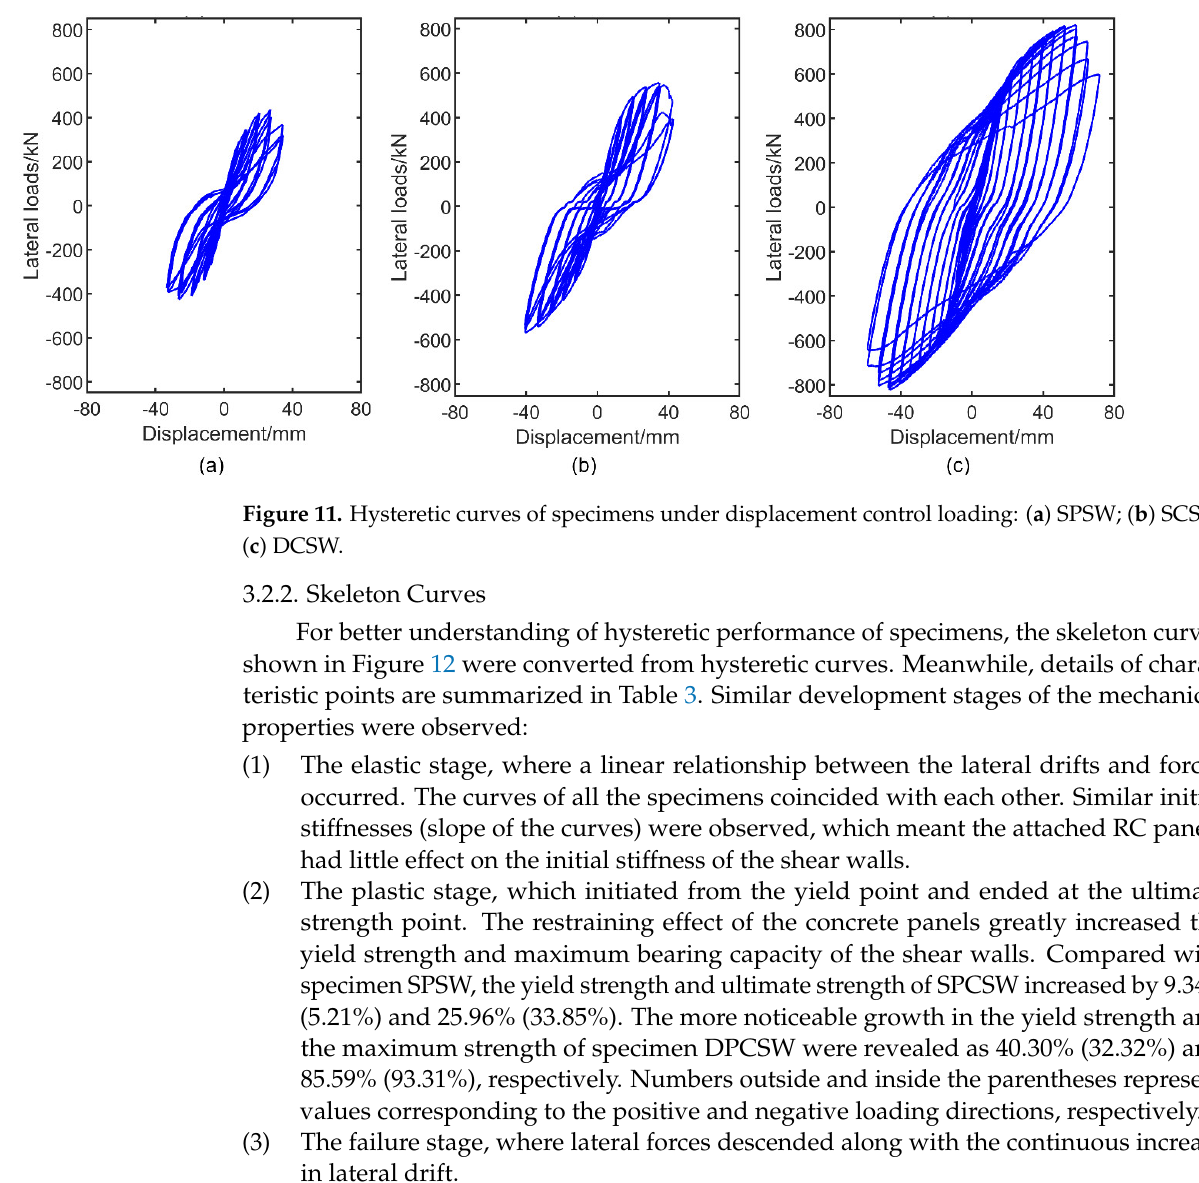
Figure 10. Failure mode of tested specimens: ( a ) performance of steel plates; ( b ) performance of prefabricated RC panels.